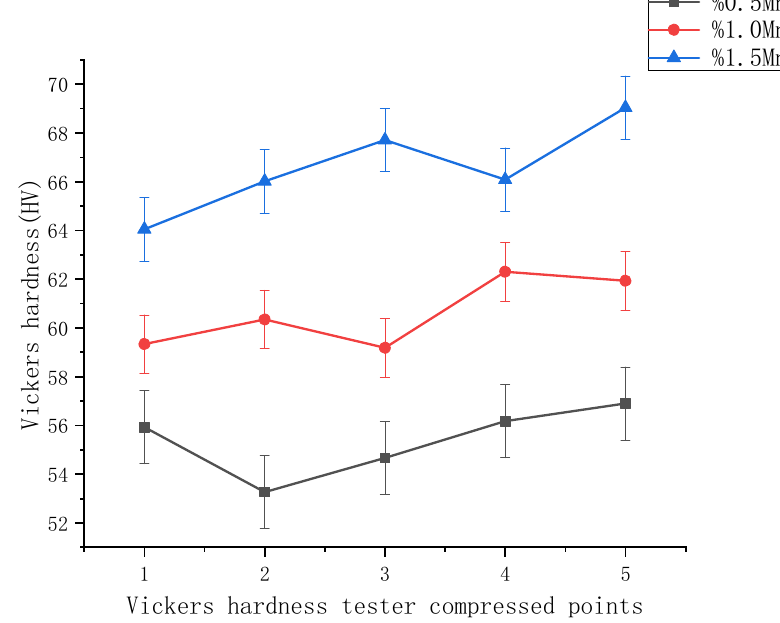
Figure 6 . Hardness curves of the three alloys . Figure 6. Hardness curves of the three